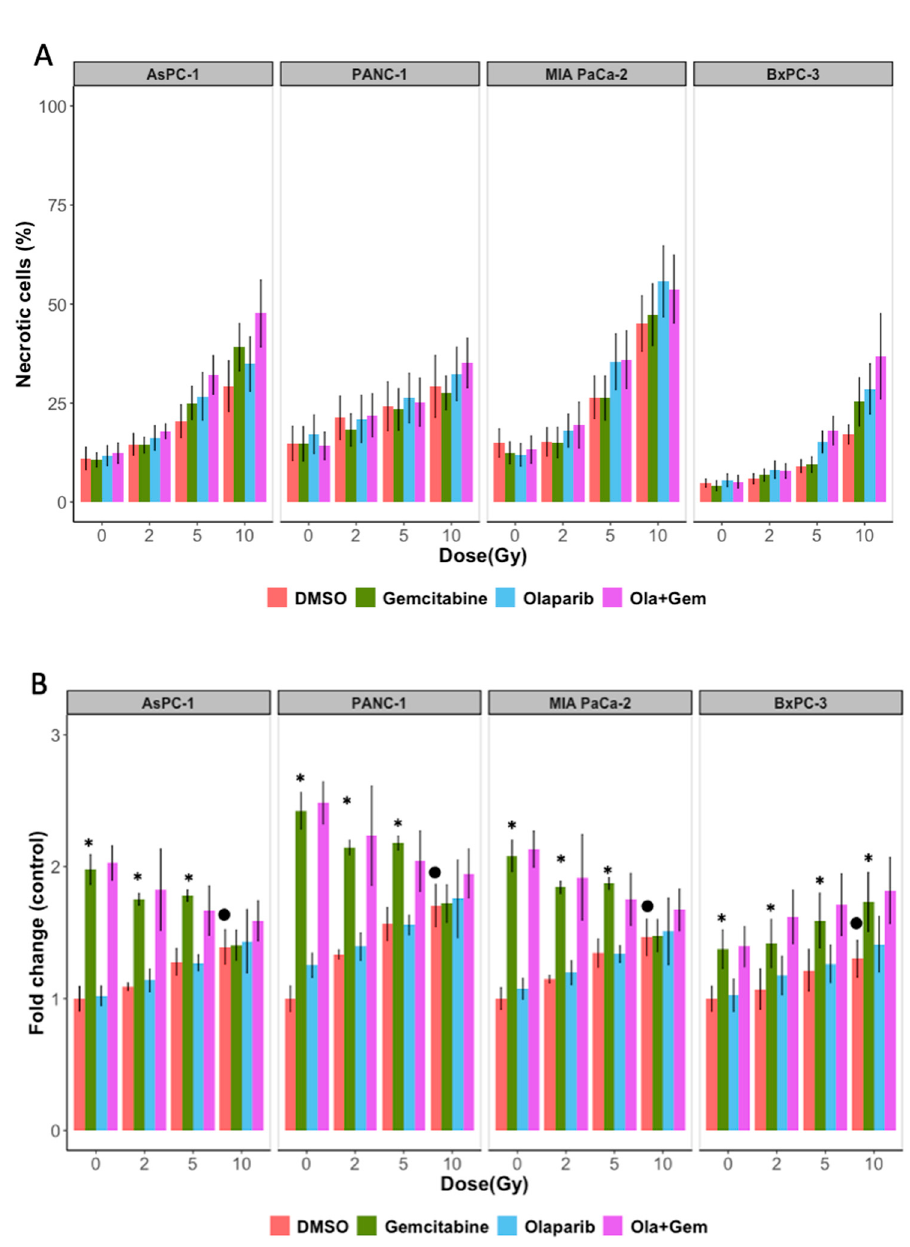
Figure 7. ( A ) Effect of irradiation (2, 5 and 10 Gy), olaparib (1 µ M) and gemcitabine (10 nM) on PANC-1, AsPC-1, MIA PaCa-2 and BxPC-3 necrosis cell death quantifications. Cells were labelled 48 h after treatment with Annexin V and propidium iodide (PI). Cells marked as Annexin V-/PI+ were determined by flow cytometry for necrosis. ( B ) Effect of irradiation (2, 5 and 10 Gy), olaparib (1 µ M) and gemcitabine (10 nM) on PANC-1, AsPC-1, MIA PaCa-2 and BxPC-3 autophagic induction. Cells were labelled 24 h after treatment using Cyto-ID ® Green detection reagent according to protocol described in materials and methods, and the mean fluorescence was determined by flow cytometry. Statistical significance is indicated: * p < 0.05 (vs. control/irradiation). • p < 0.05 (vs. Control).